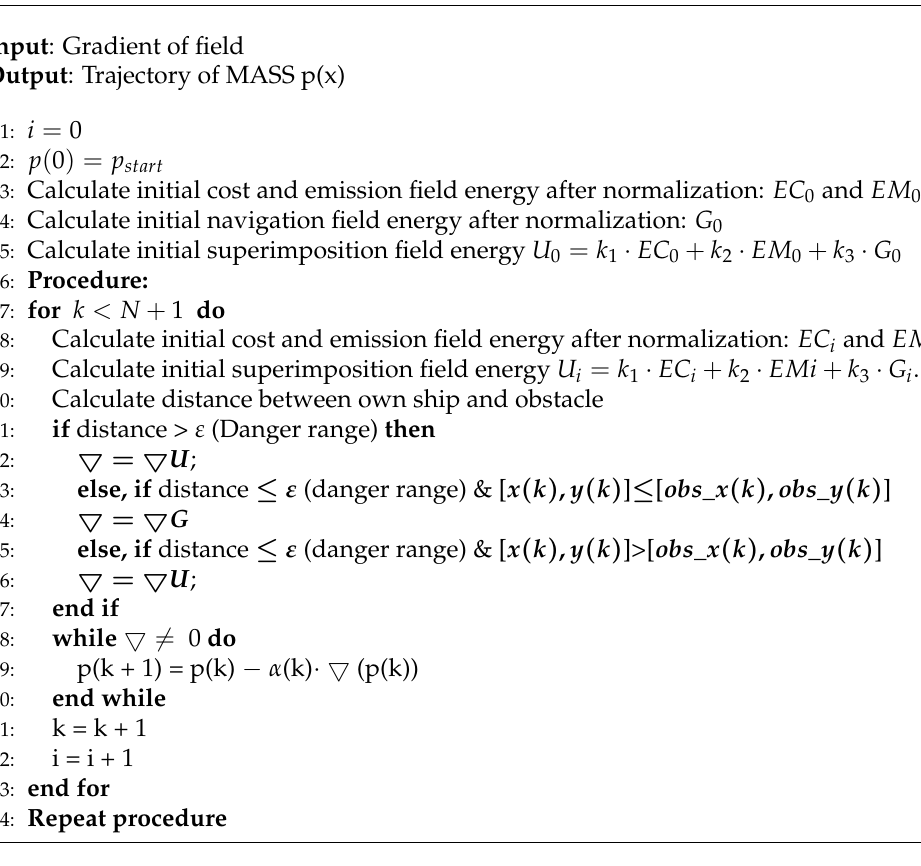
Algorithm 1 Local path